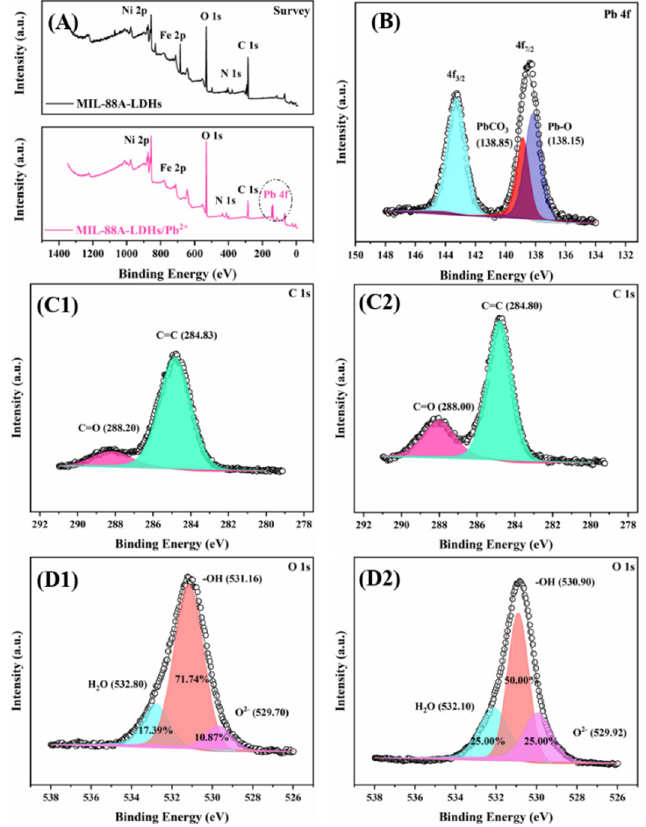
Figure 8. XPS spectra of MIL-88A-LDHs and MIL-88A-LDHs/Pb 2+ : ( A ) survey, ( B ) Pb 4f, ( C1 , C2 ) C 1s, ( D1 , D2 ) O1s.